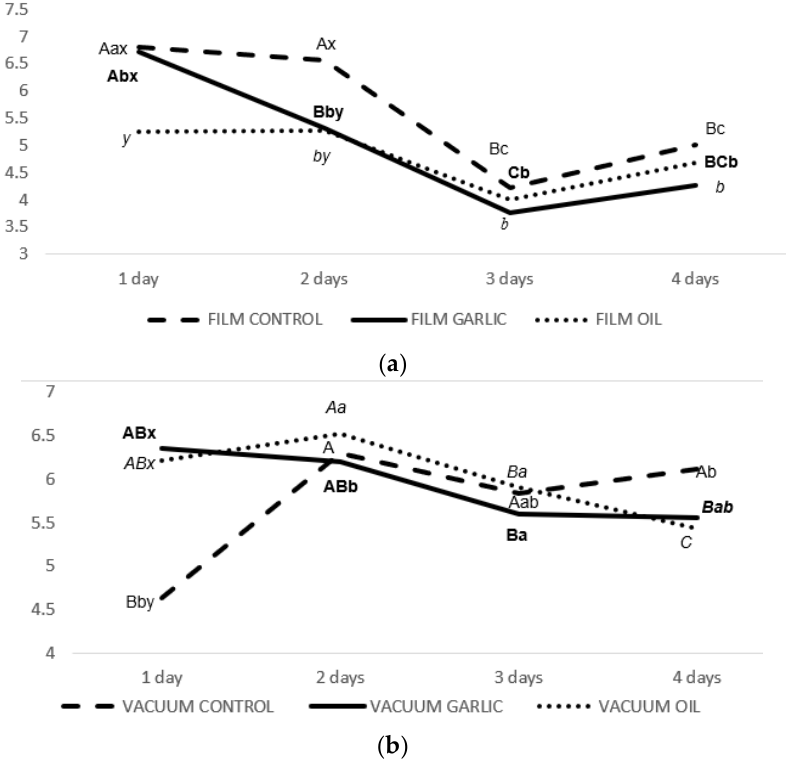
Table 2. Values of p for studied e ff ects (plant extract addition, pig sex, exposure time and packaging type) on consumer visual appraisal scores of pork meat.